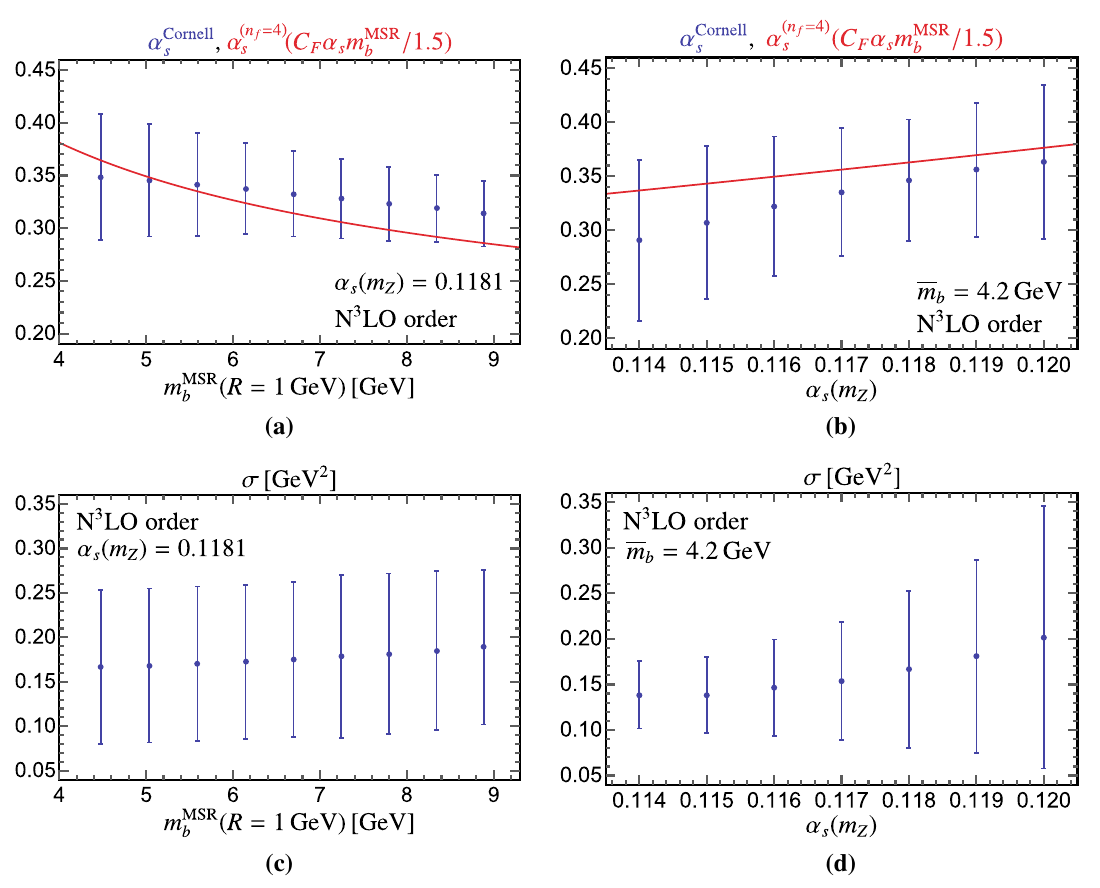
Fig. 13 DependenceoftheCornellparameters α Cornell s (uppertwopan- els) and σ (lower two panels) with the MSR bottom mass (leftmost two panels) and the QCD coupling constant at the Z-pole (rightmost two